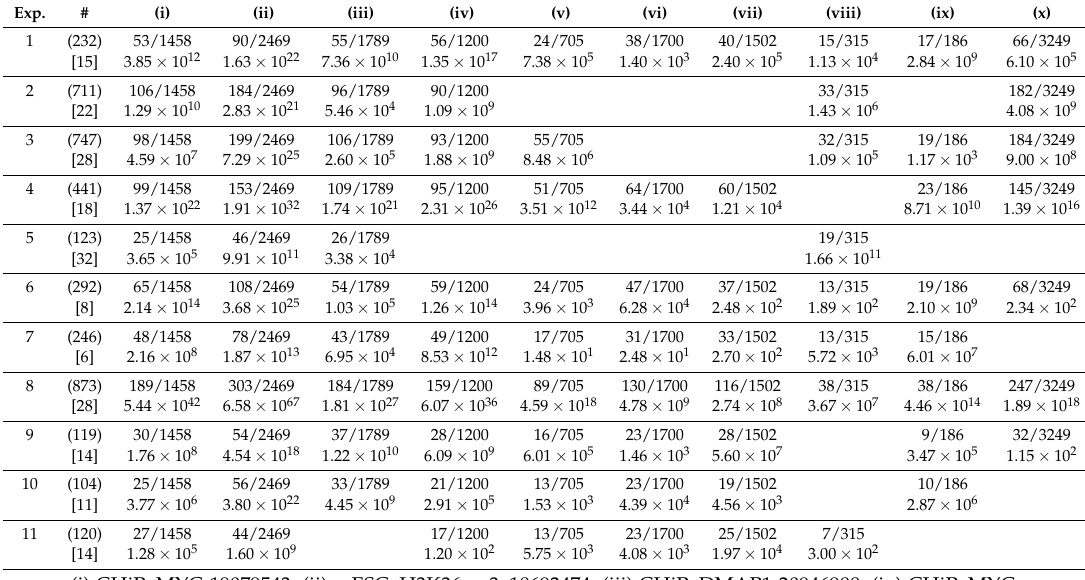
Table 9. In each of the 11 experiments, 20 top-ranked significant terms in the Embryonic Stem Cell Atlas from Pluripotency Evidence (ESCAPE) whose set of associated genes significantly overlapped with the set of genes selected for each experiment were identified.